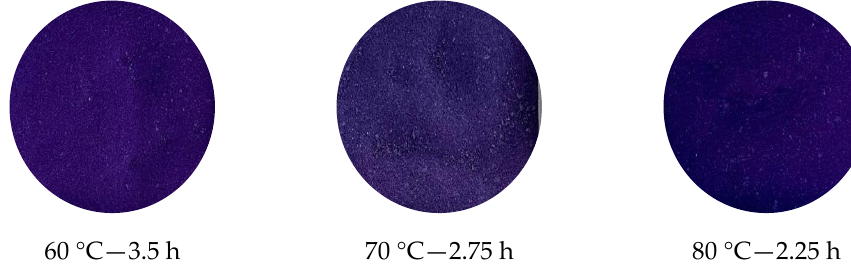
Figure 7. Color of magenta powder at different foam-mat drying temperatures and times. Table 8. The color parameters of magenta powder under different drying